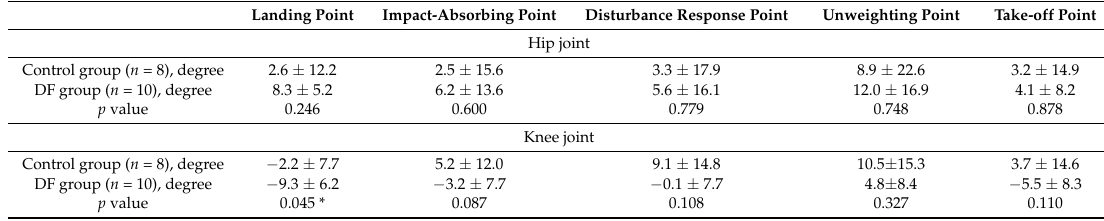
Table 5. Hip and knee angles in the frontal plane at each